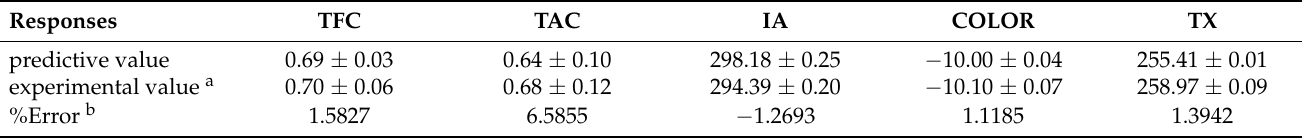
Table 2. Predicted and experimental